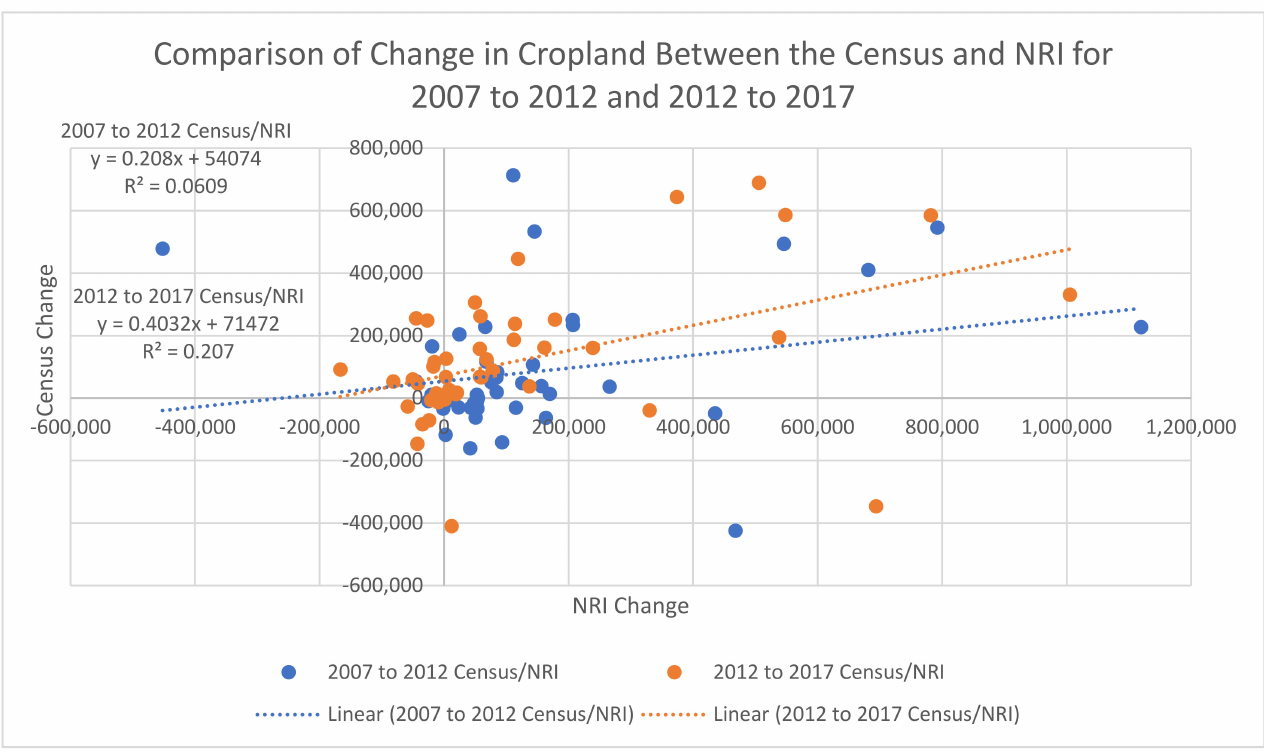
Figure 3. The relationship in total cropland change estimated using the National Resources Inventory (NRI) and the Census of Agriculture (Census) for 2007 to 2012 and 2012 to